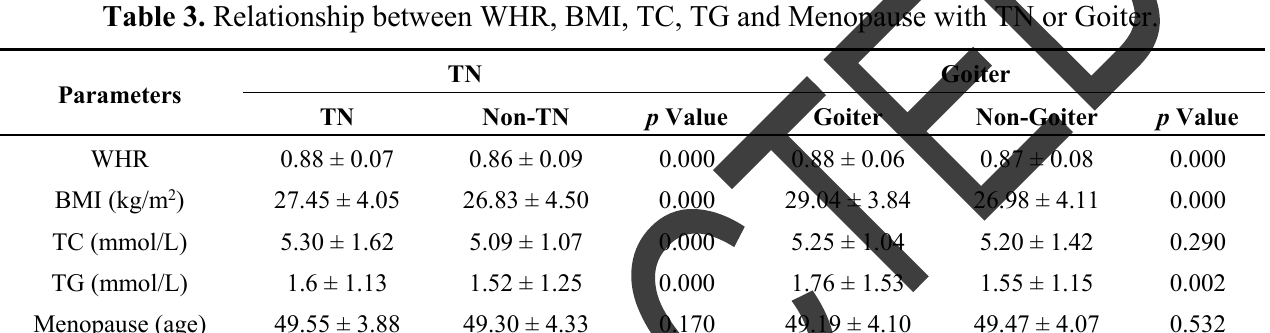
Table 3. Relationship between WHR, BMI, TC, TG and Menopause with TN or Goiter.